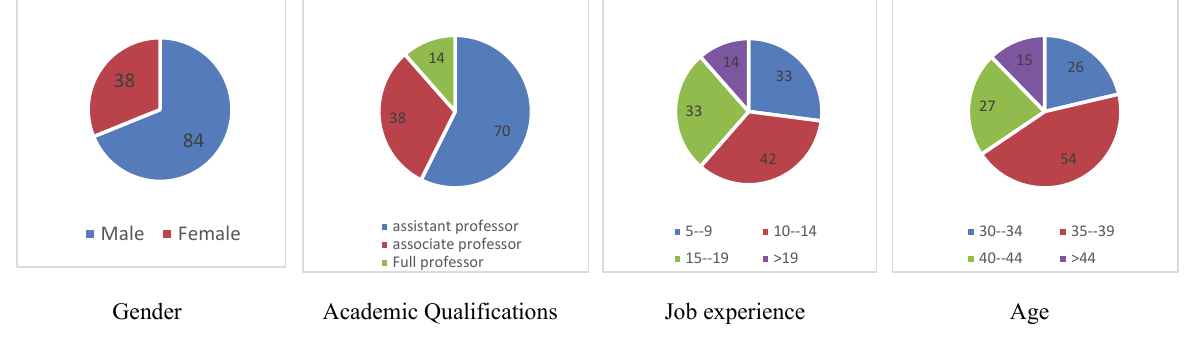
Fig. 2. Personal characteristics of the